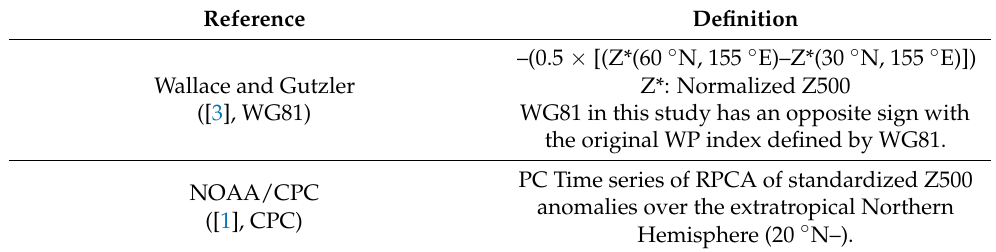
Table 2. Definitions of the WP indices.